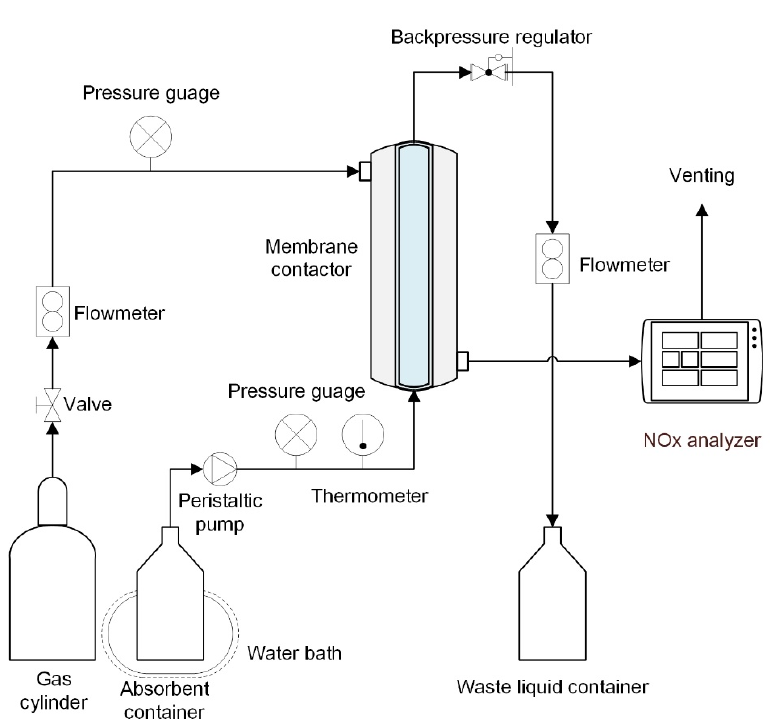
Figure 1. Schematic diagram of the ceramic HFMC.